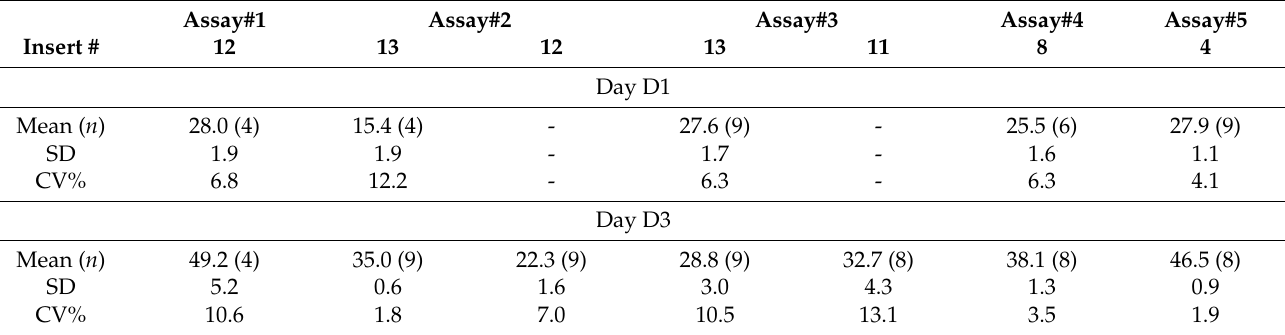
Table 4. TEWL (g/m 2 h) measurements performed before sample application (D1) and after the assay ended